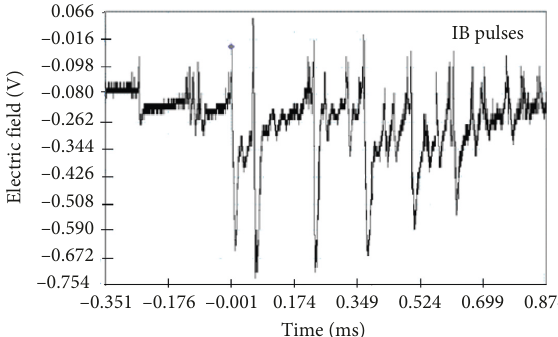
Figure 4: An example of the electric field signature of cloud flash consisting of two stages.